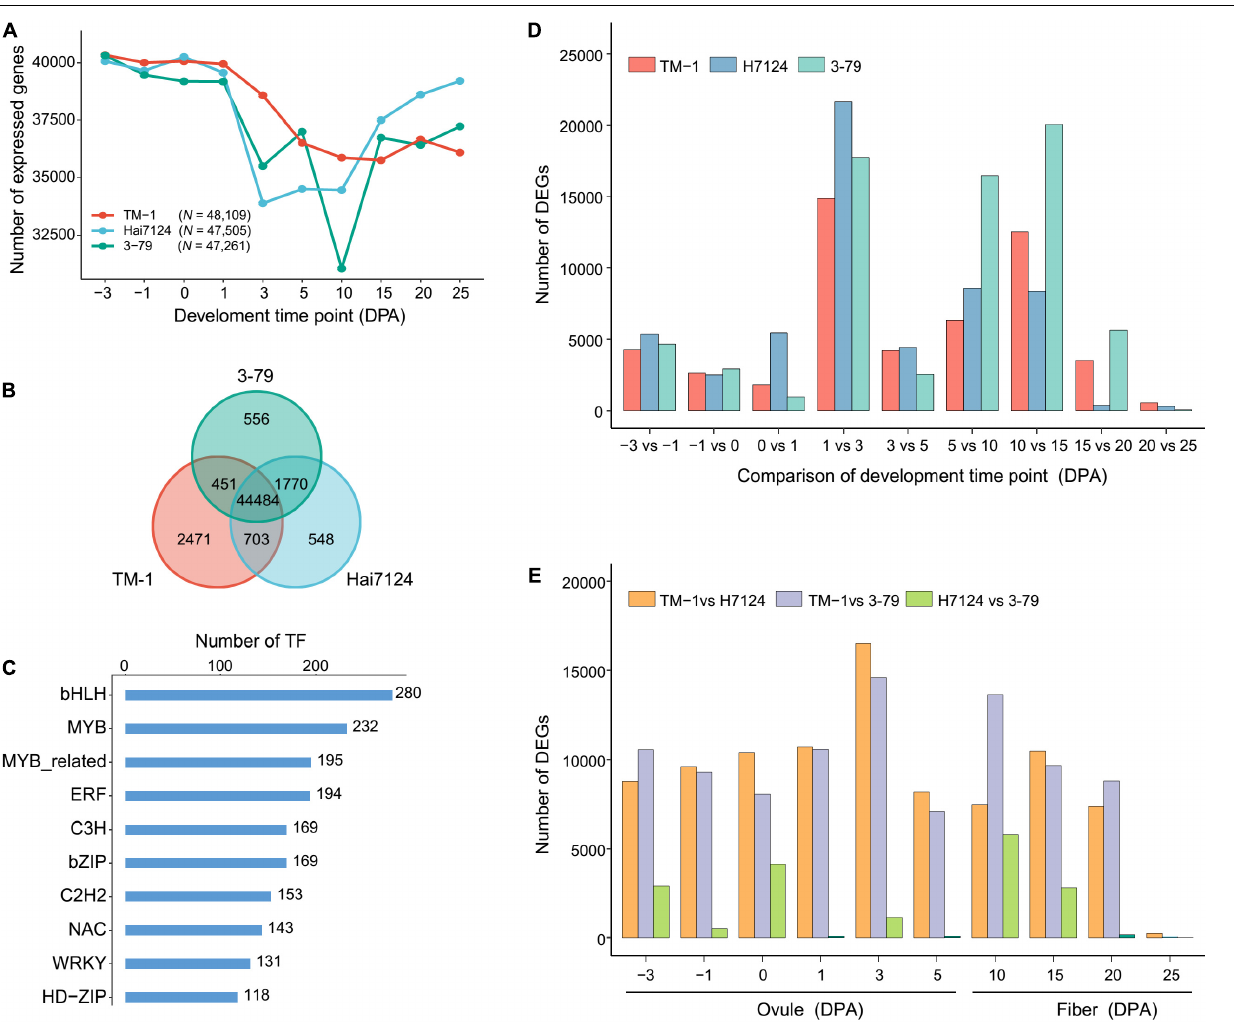
FIGURE 1 | Statistical analysis of expressed genes, TFs, and DEGs during fiber development. (A) Line charts showing the number of expressed genes during different fiber developmental stages in TM-1, 3-79, Hai7124. N represents the total number of expressed genes for the cultivar. (B) Venn diagram of the expressed genes. Each color represents one cultivar. (C) Frequency of the transcription factors among 44,484 expressed genes. Each number represents the number of gene families. (D) Statistics of DEGs within three cotton cultivars. (E) Statistics of DEGs between three cotton